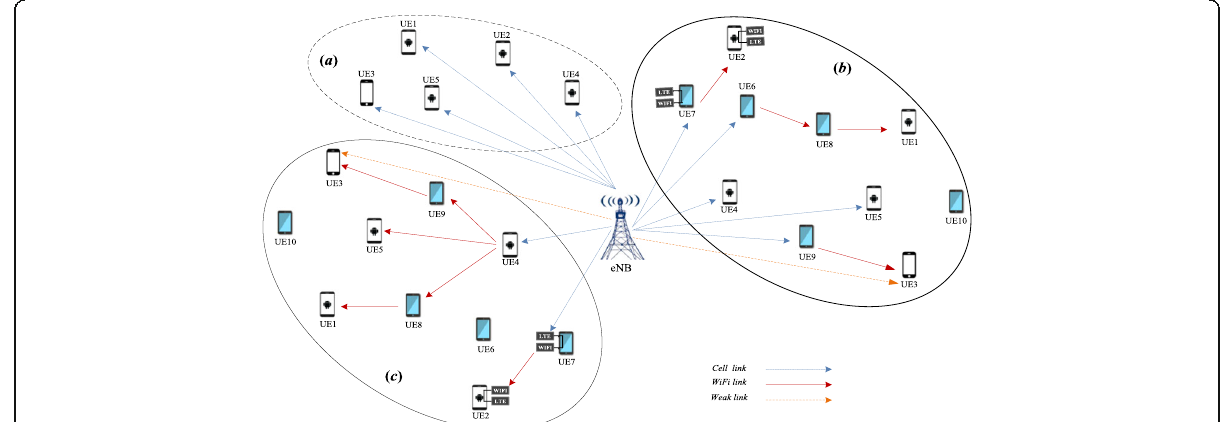
Fig. 1 Example for cellular network topology with outband D2D